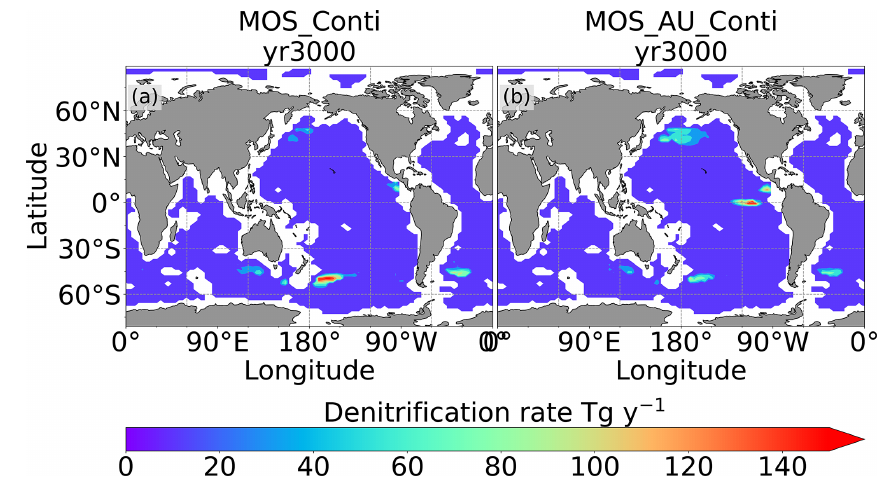
Figure B3. Denitrification rate at depth 3000–6000m in year 3000, where the oxygen level is lower than 5µmolm − 3 , caused by the remineralization of continuously sunken MOS biomass.